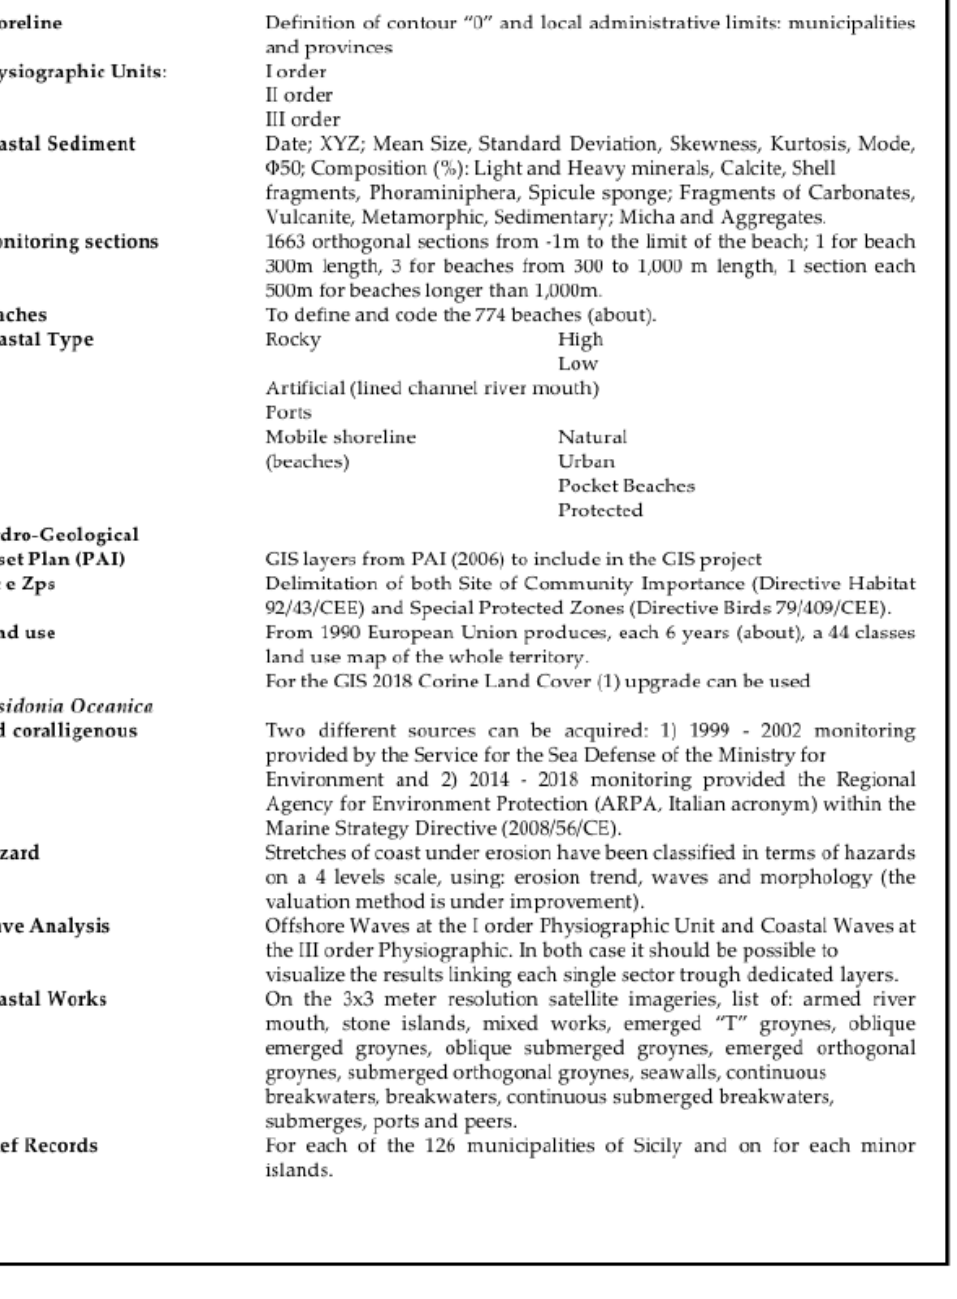
Figure 5. Concise record of the GIS structure. (1) “Technical Guidelines” (EEA, 2017) [23] based on CLC2006 Technical guidelines (EEA Technical Report No 17/2007) [24] with the CLC2012 Addendum to the CLC2006 Technical guidelines (ETC/SIA report) [25].